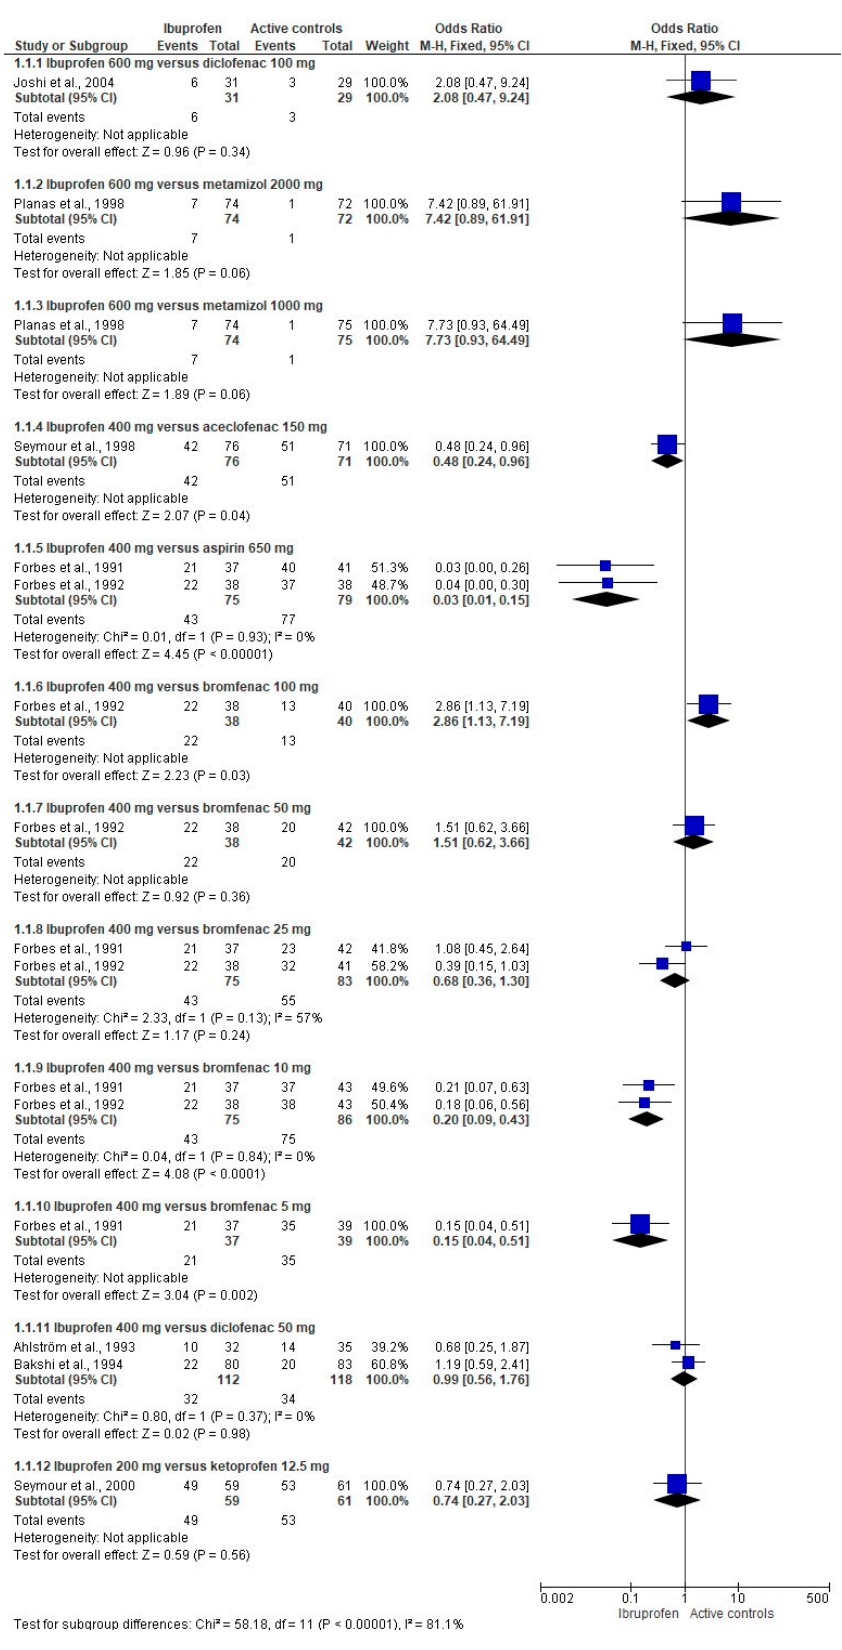
Figure 3. Meta-analysis of the number of patients using the rescue medication after third molar extraction.